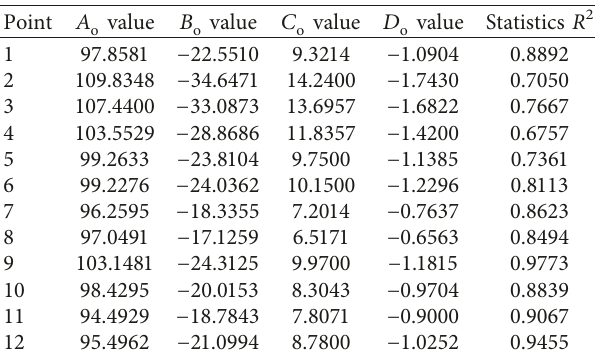
Table 5: Fit parameters between radiation noise and oil supply.